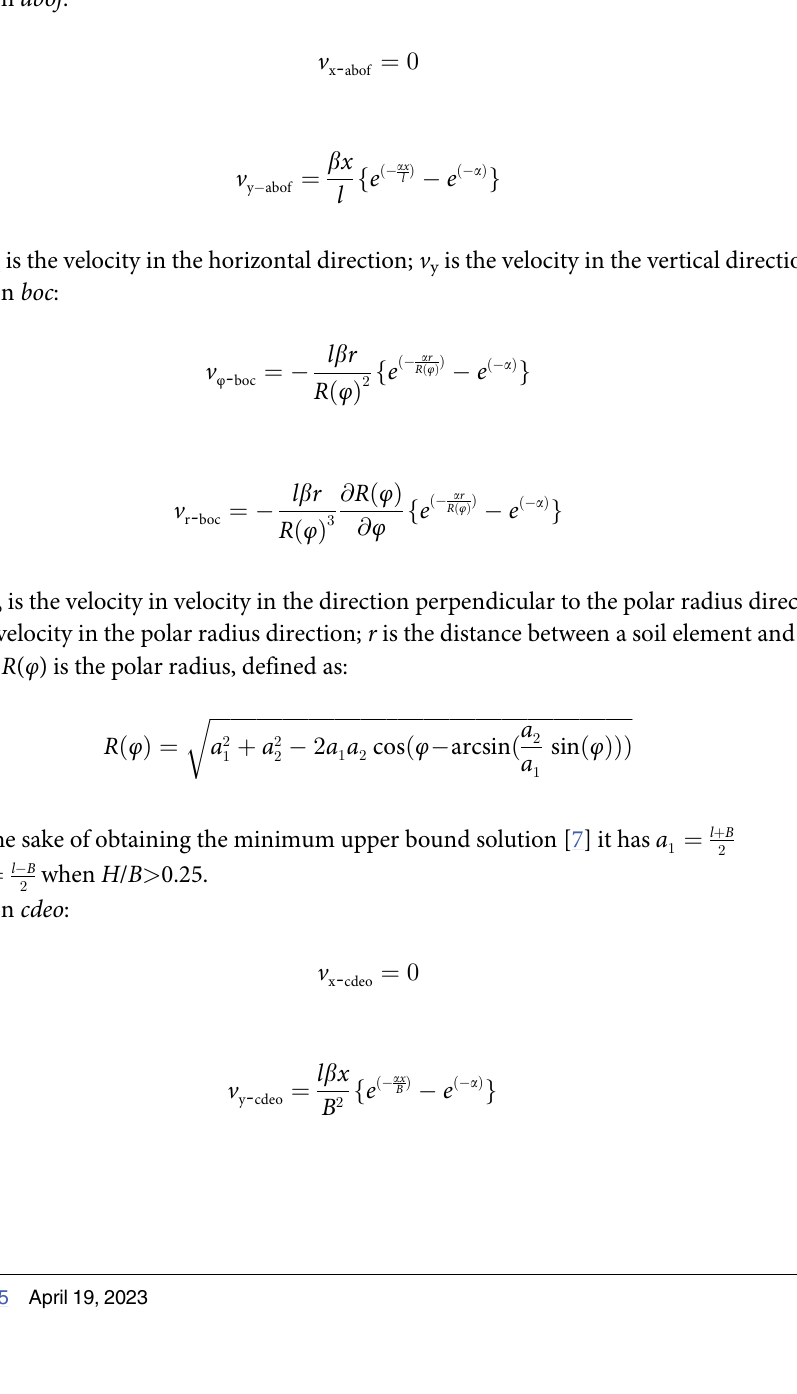
adopt a rectangular coordinate system and consider the soil flow direction as positive. Region boc adopts a polar coordinate system, which is specified to take the counterclockwise direction as positive. Region abof :